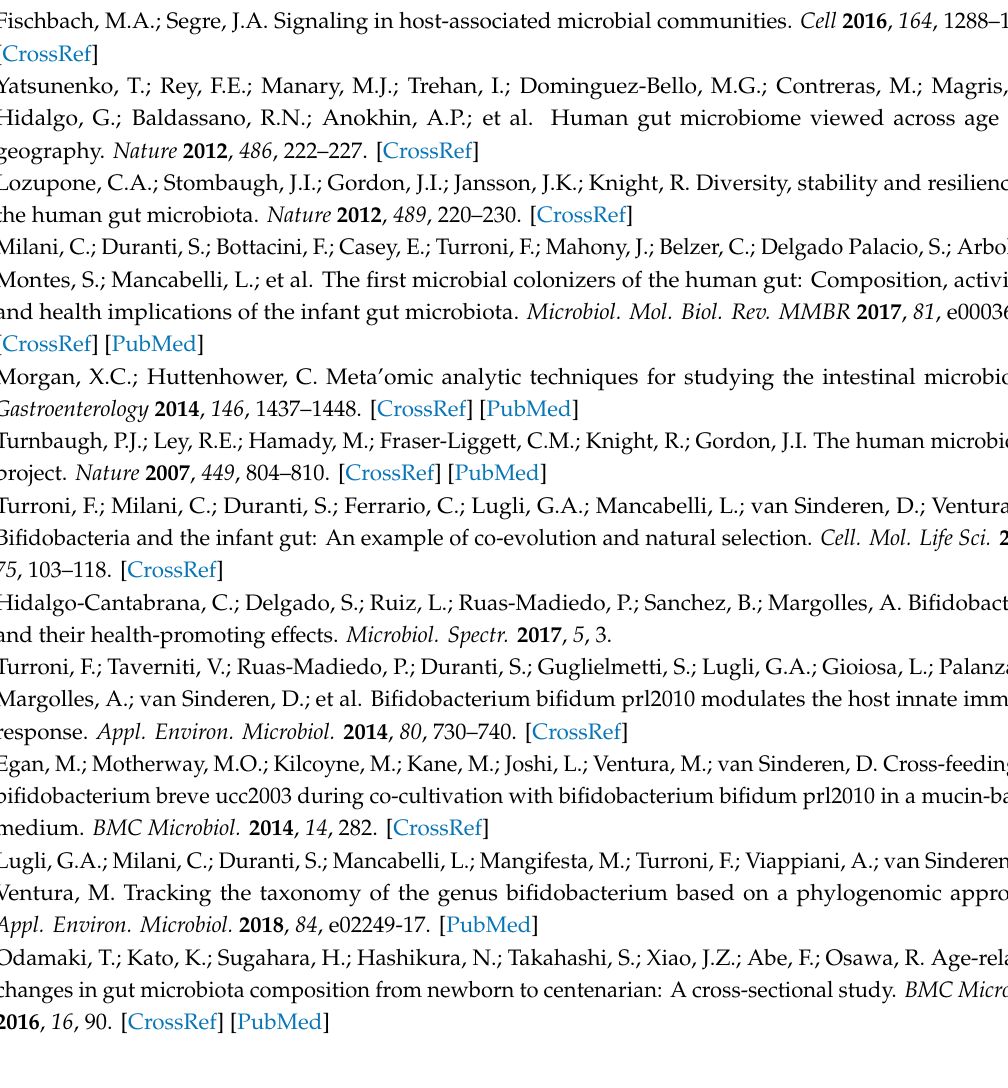
Supplementary Table S1. Quality-filtering table of 16S rRNA gene and ITS bifidobacterial profiling datasets. Supplementary Table S2. Bifidobacterial genomes used to design the myBaits. Supplementary Table S3. Bifidobacterial genomes used to perform comparative genomics